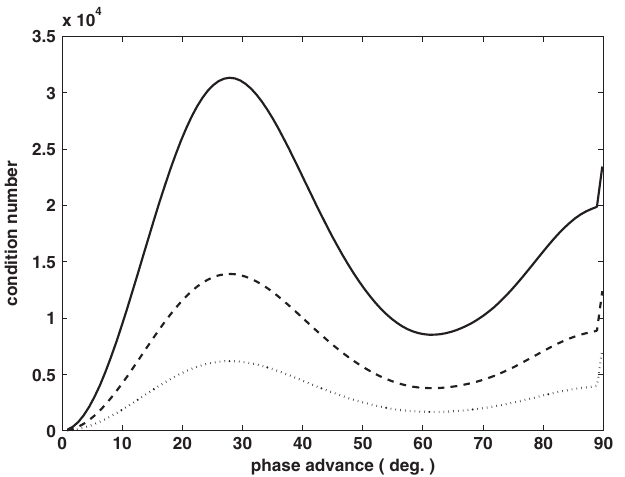
FIG. 6. Value of (6) plotted against cell phase advance for (cid:6) -function 40 m (solid line) and 70 m (dashed line). (or M ) plotted against cell X Y